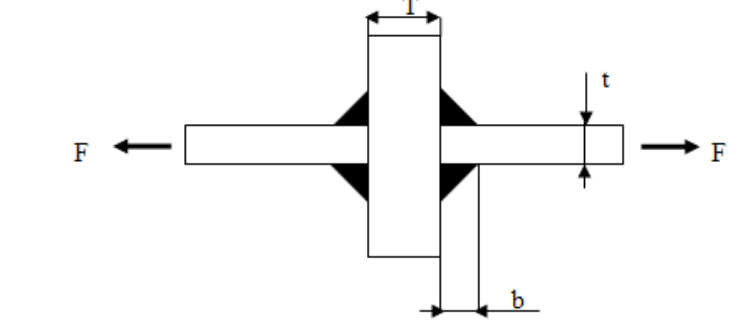
Figura 1: Tipologia di giunto saldato